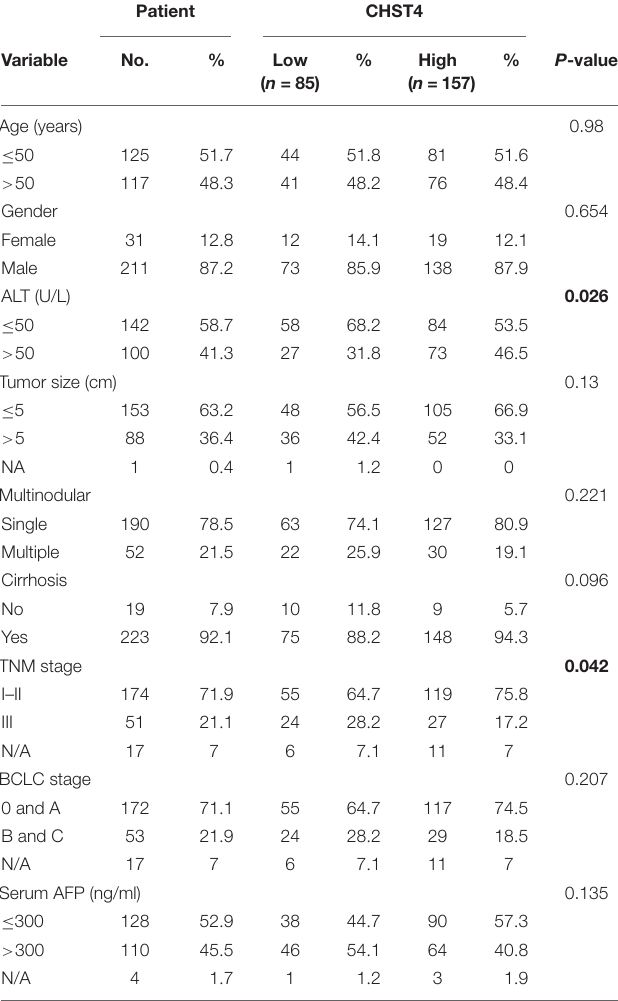
TABLE 1 | Correlation between carbohydrate sulfotransferase 4 (CHST4) expression and clinicopathologic characteristics of HBV-HCC patients from the GSE14520